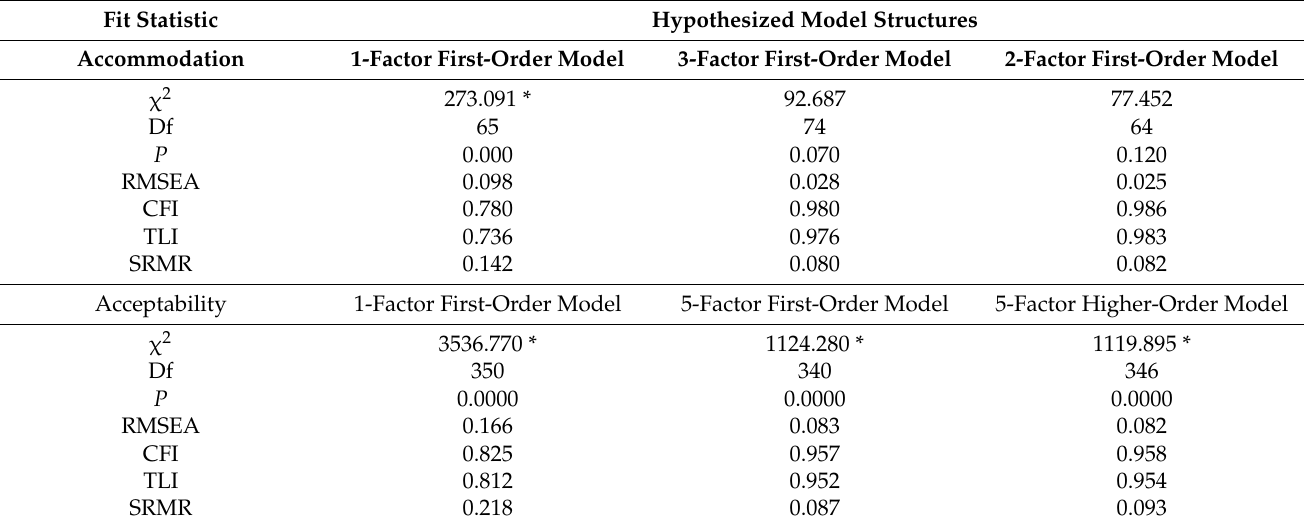
Table 3. Goodness-of-fit Statistics for the Accommodation and Acceptability Dimensions.